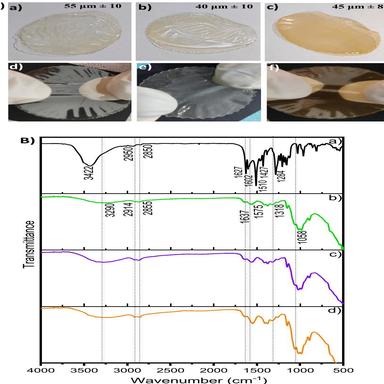
(A) Membranes formed by the casting method of: a) chitosan, b) chitosan/glycerol 30 %, c) chitosan/glycerol 30 %/turmeric1.5 % and the same membranes, respectively, under stretching (d–f). The membranes thicknesses are shown in the inset. (B) FTIR spectra in vibrational regions from 4000 to 500 cm− 1 for: a) turmeric, b) chitosan, c) chitosan/glycerol 30 %, d) chitosan/glycerol 30 %/turmeric1.5 %.